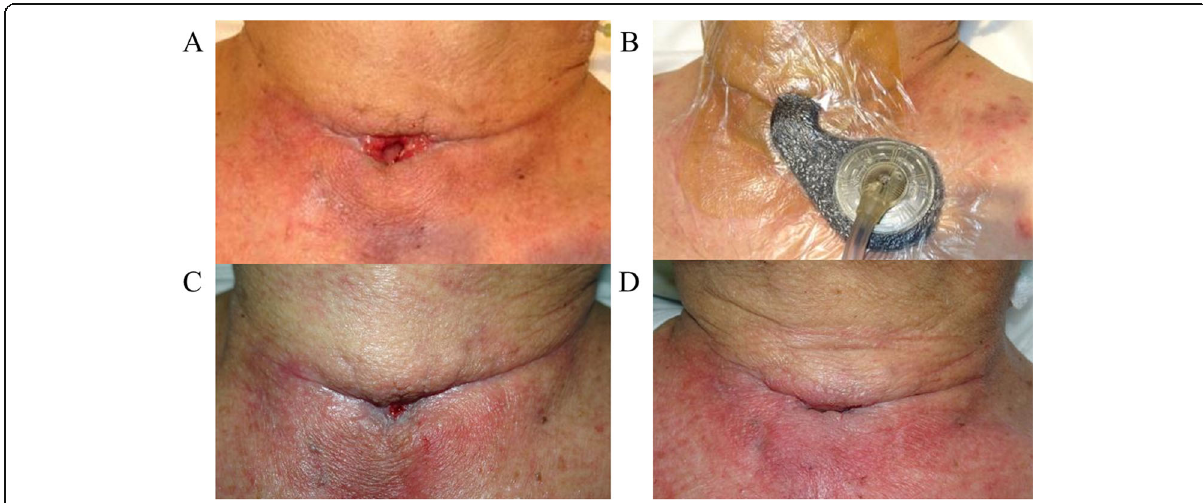
Fig. 3 a Appearance of the cervical wound on the 61st POD. Exudate constantly emerging from the fistula caused peripheral dermatitis. b NPWT was initiated for continuous aspiration of exudate and skin protection. c Appearance of the cervical wound on the 73rd POD (13th day after NPWT initiation). Granulation is in development, the skin closes in, and the fistula is shrinking. d Appearance of the cervical wound on the 81st POD (21st day after NPWT initiation). The fistula had closed, and no exudate was